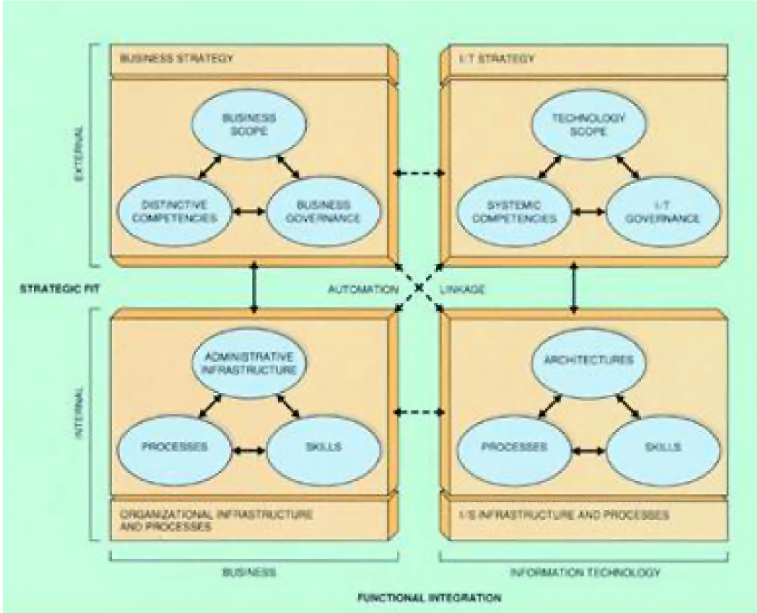
Figure 1. Strategic Alignment Model (Henderson & Venkatraman,